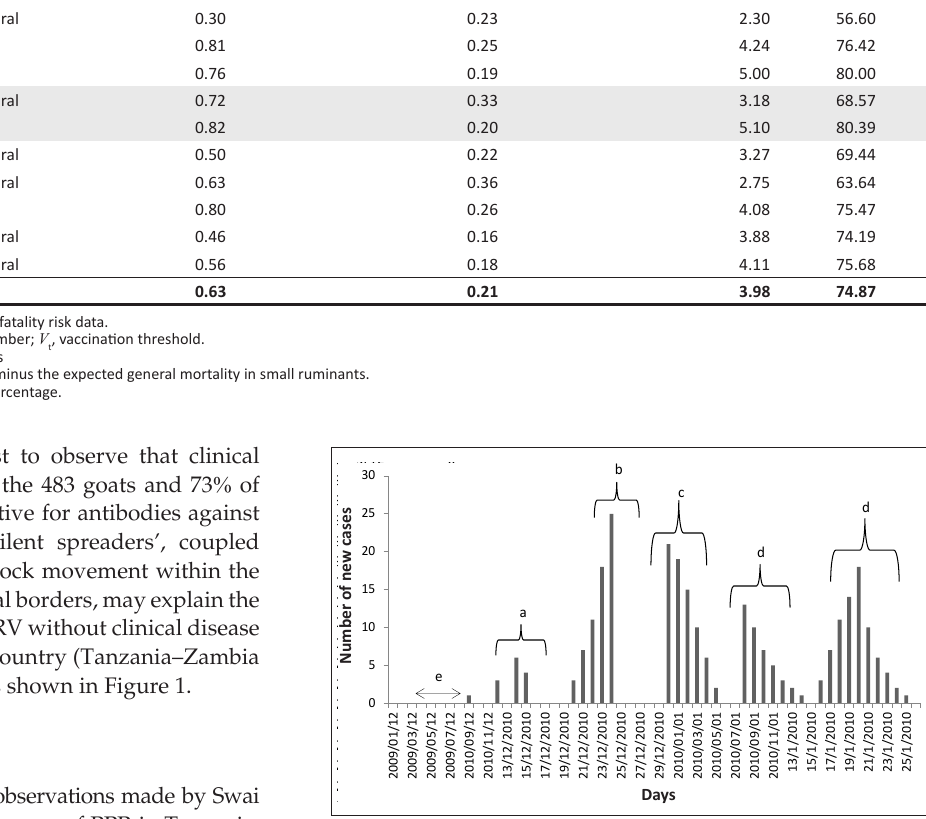
TABLE 3b: Estimation of effective reproductive number for peste des petits ruminants virus infection of pastoral sheep and goat flocks in Tanzania, using morbidity and case fatality risk indices. Region District Arusha Karatu